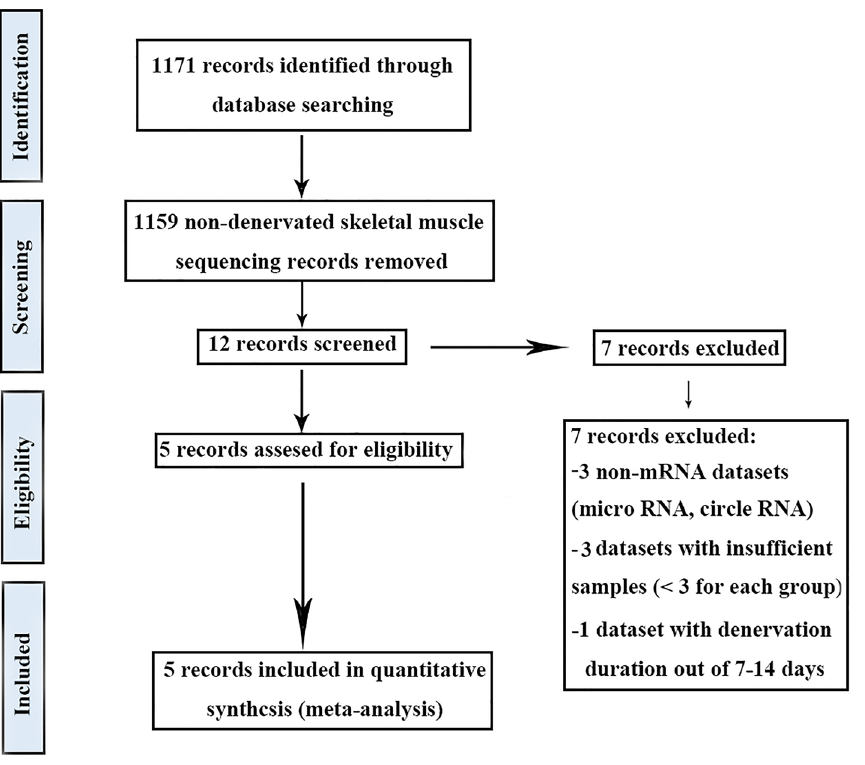
Figure 1. Flow chart of literature search in the meta-analysis.